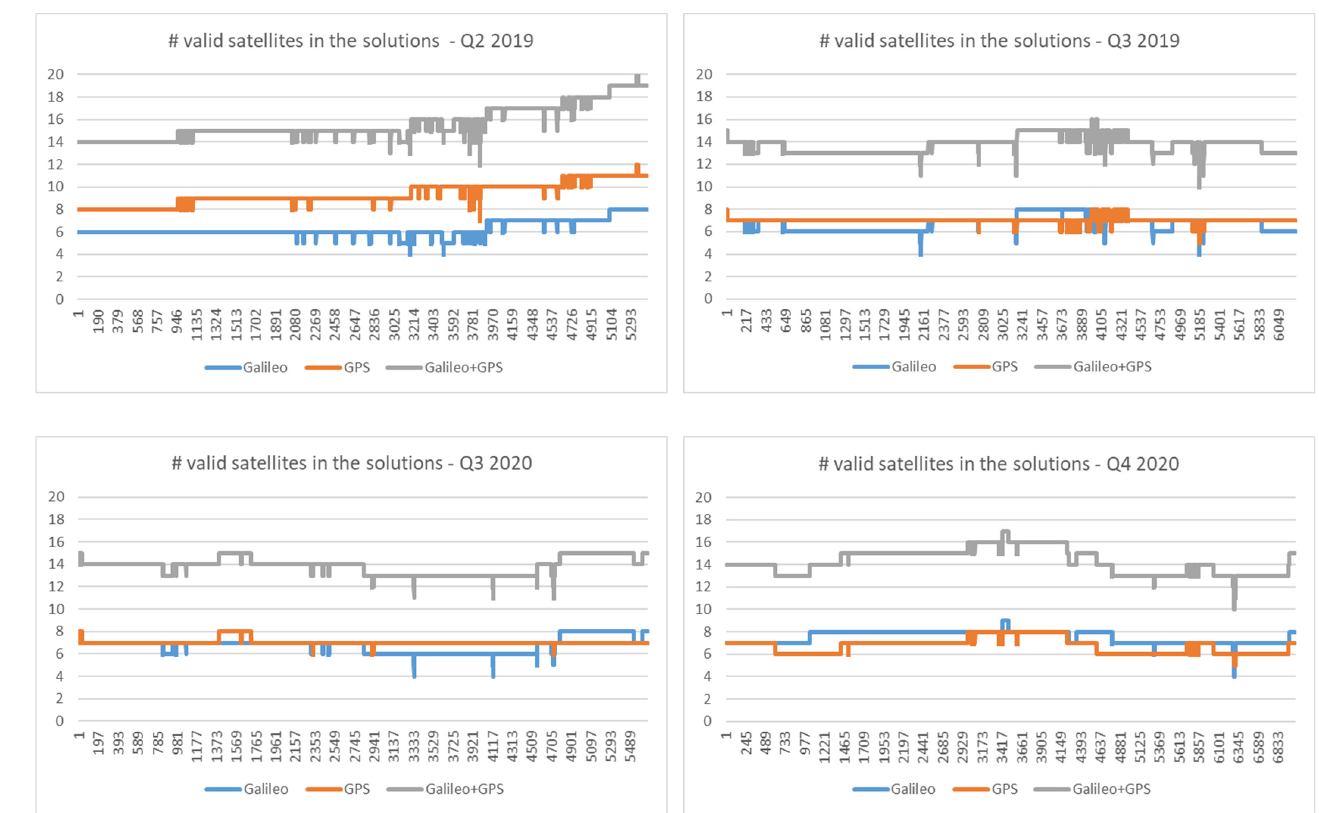
Figure 9. Number of valid satellites used in the aerial solutions estimations. In the skyplots below, the fuchsia color indicates satellites with triple frequency, and the blue color indicates satellites with dual frequency (oldest GPS satellites). In the satellite eleva- tion plots, the green and orange colors indicate satellites with SNR (Signal-to-Noise-Ratio) over 40 dBHz, which is what happens for most of the satellites above the 20° elevation.